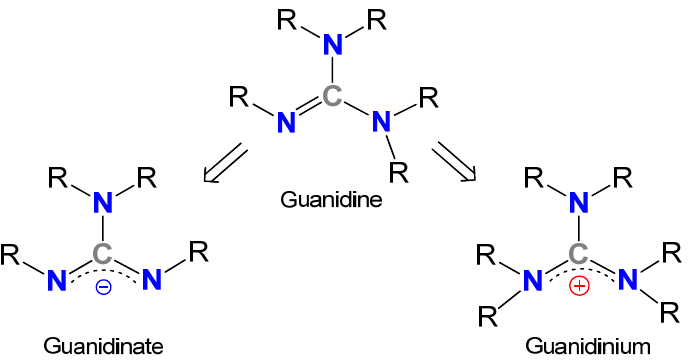
Figure 1. General structures of guanidines, guanidinates and guanidinium cations.